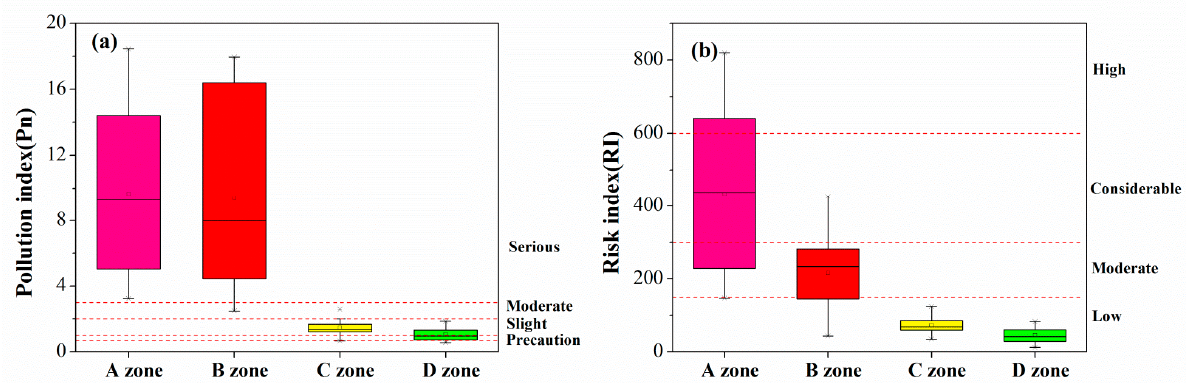
Figure 2. Boxplot of pollution index ( a ) and risk index ( b ) for heavy metals in the four zones. As shown in Figure 2b, the higher potential ecological risk was found in A and B zones in comparison with C and D zones. More specifically, in the A zone, the single ecological risk index (E i ) of Cd was higher than 320 (E i = 389.4), indicating a higher contribution r r of Cd to potential ecological risk (Figure S1a). In the B zone, except Cd, the E i value r of Cu was larger than 40 (E i = 63.0), posing a moderate potential ecological risk though r RI being lower risk level than non-ferrous metals smelter (Figure S1b). In the C